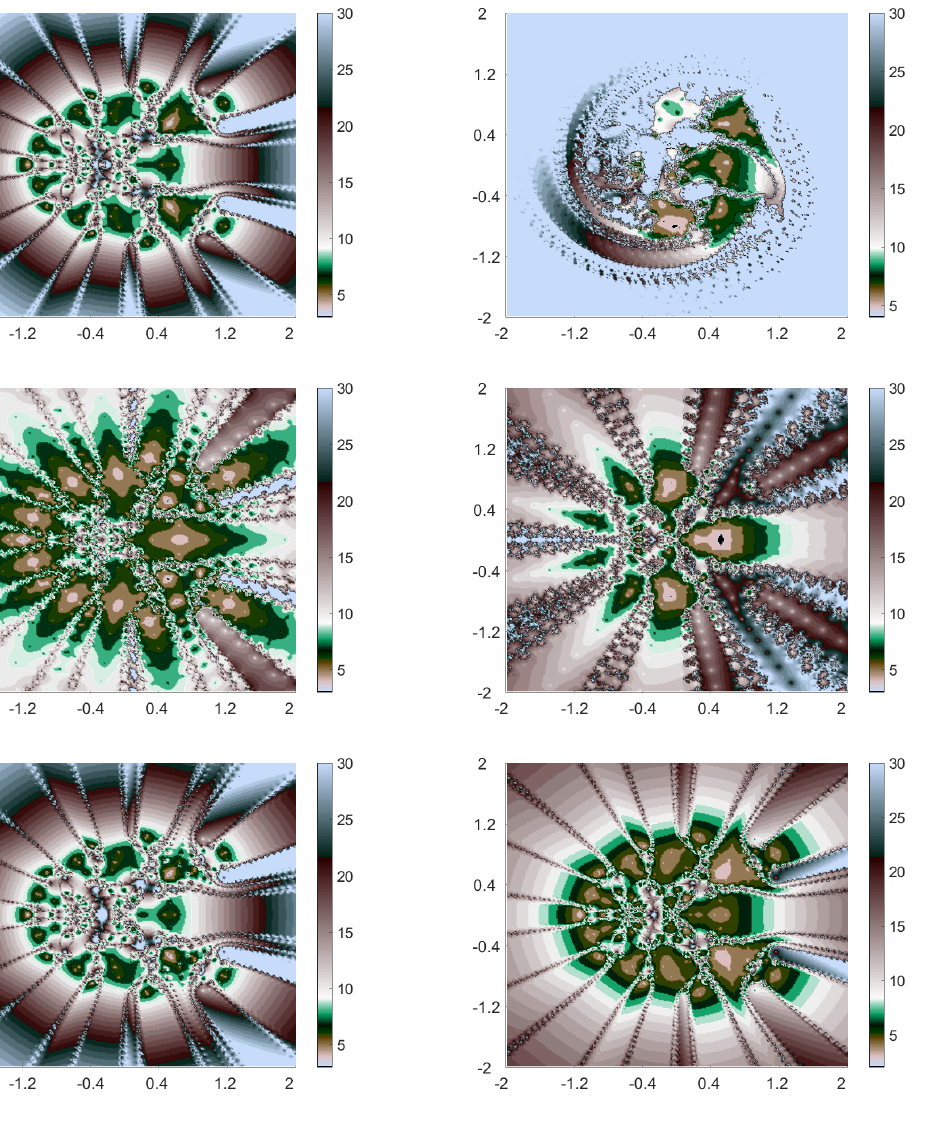
Figure 2. Visualisation of polynomiographs by various methods for p ( z ) = z 5 + 2 z 4 + 2 z 3 − 3 z 2 − 1: RK iteration ( Top Left ); RK iteration with s-convexity ( Top Right ); Mann iteration ( Middle Left ); Ishikawa iteration ( Middle Right ); S-iteration ( Bottom Left ), and Picard–Mann iteration ( Bottom Right